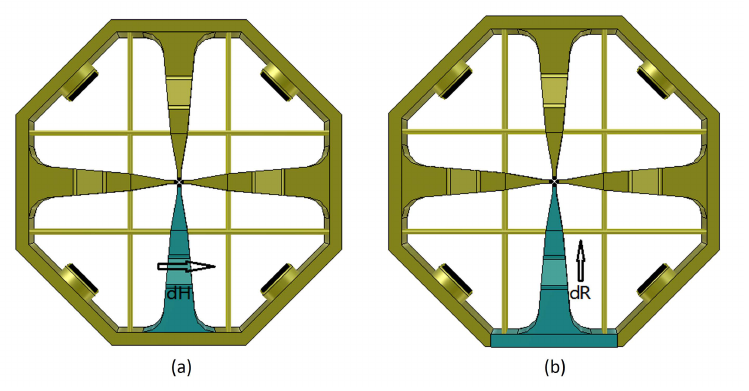
Figure 14. Vane deviation ( a ) and skew ( b ) errors.